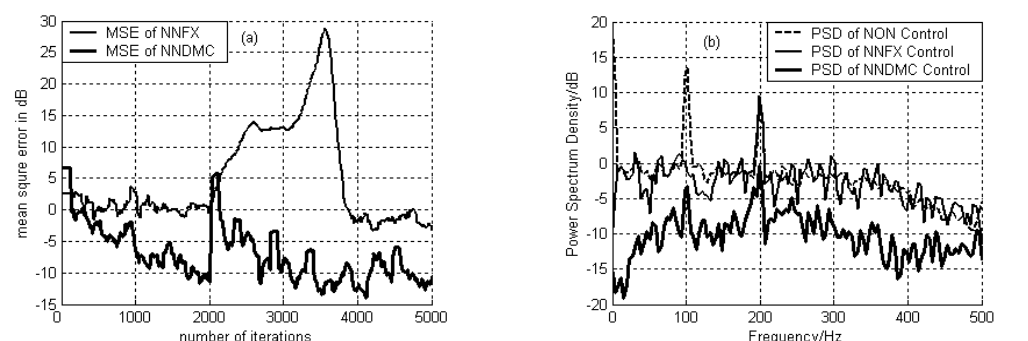
Fig. 7. (a) The error curves of proposed nonlinear DMC algorithm and NN-based nonlinear FXLMS algorithm for ANC system with on-line secondary path modeling. (b) Power spectrum of active noise canceling errors for ANC system with on-line secondary path modeling. The thin line for NN-based controller, the thick line for nonlinear DMC controller, and the dished line for ANC turn off. y ( k ) = − u ( k − 1) − 1 . 5 u ( k − 2) + u ( k − 3)